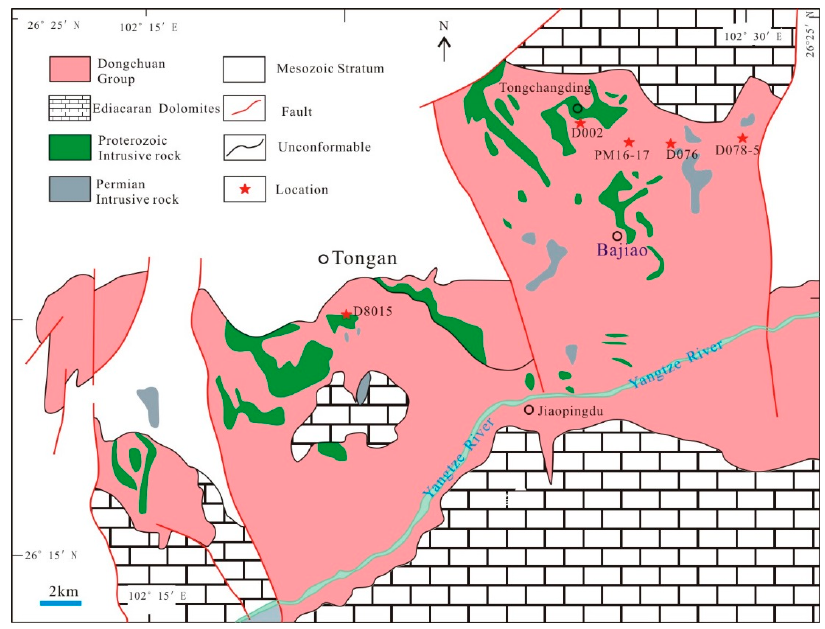
Figure 2. Simplified geological map of the study area (modified after paper [27]).